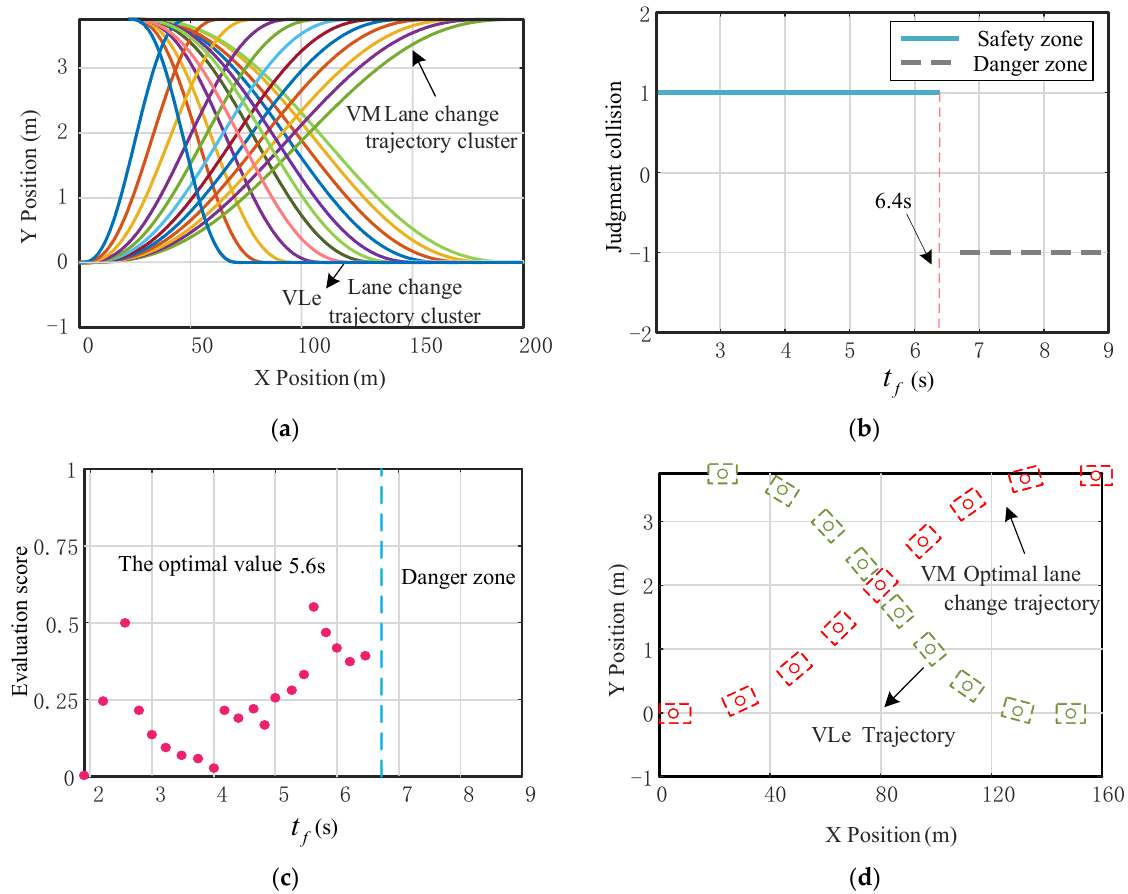
Figure 11. ( a ) Subject vehicle lane changing trajectory cluster and front vehicle trajectory; ( b ) Results of the safe collision avoidance algorithm; ( c ) Results based on Topsis algorithm scores; ( d ) Optimal lane change trajectory for the subject vehicle.